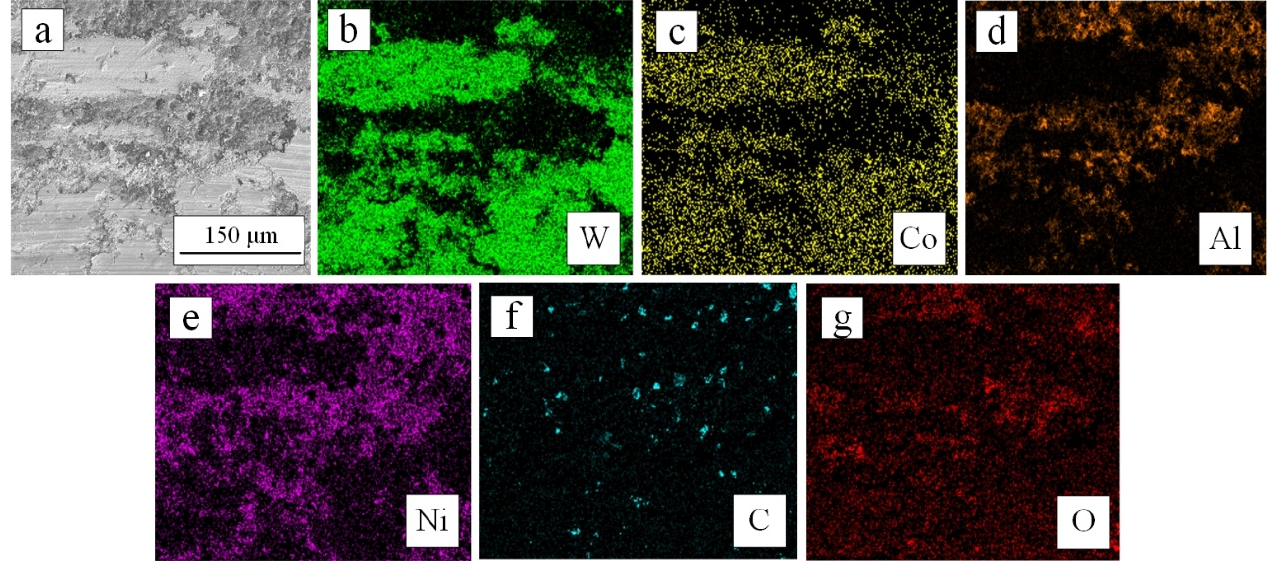
Figure 10. ( a – g ) SEM image and EDS mapping on the worn surface of a 500 °C heat-treated coating after tribology test.